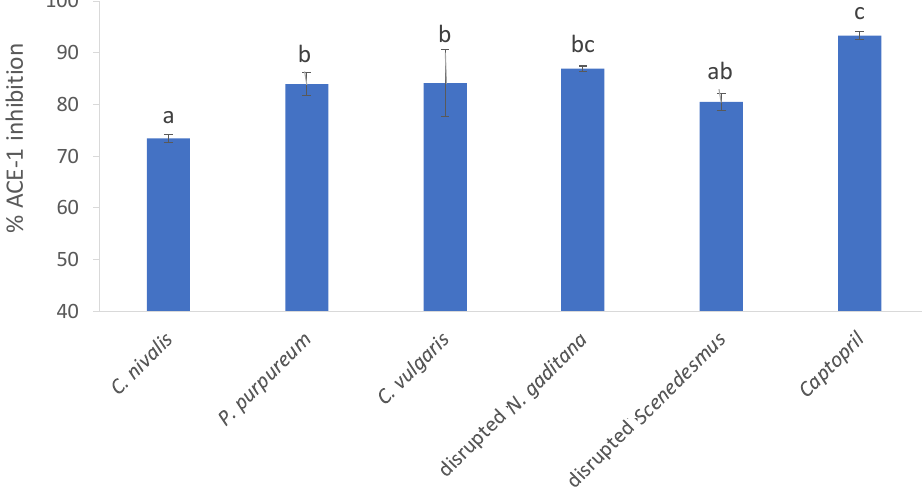
Figure 5. ACE-1 (angiotensin-1-converting enzyme) inhibition by microalgae assayed at a concen- tration of 1 mg/mL. Values are significantly different when bars are not labeled with a common lowercase letter.